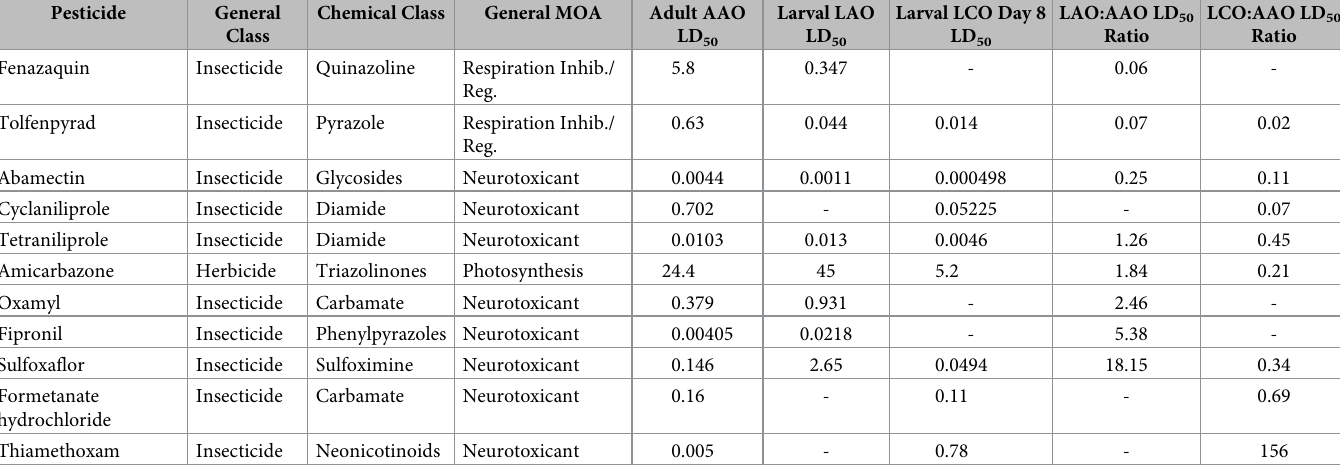
Table 4. Comparison of honey bee ( Apis mellifera ) adult acute (AAO; OECD TG 213), larval acute (LAO; OECD TG 237), and Larval Chronic Oral (LCO; OECD GD 239) technical grade active grade ingredients (TGAI) LD 50 values (N = 11). Units for the adult and larval LD 50 values are μ g ai bee -1 and μ g ai larva -1 , respectively.